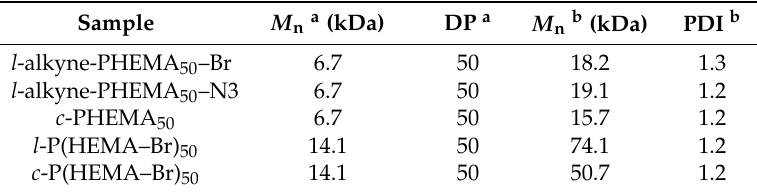
Figure 3. SEC elution traces of l -P(HEMA–Br) 50 (A) and c -P(HEMA–Br) 50 (B) using DMF as the eluent. Table 1. Summary of linear and cyclic polymers synthesized.